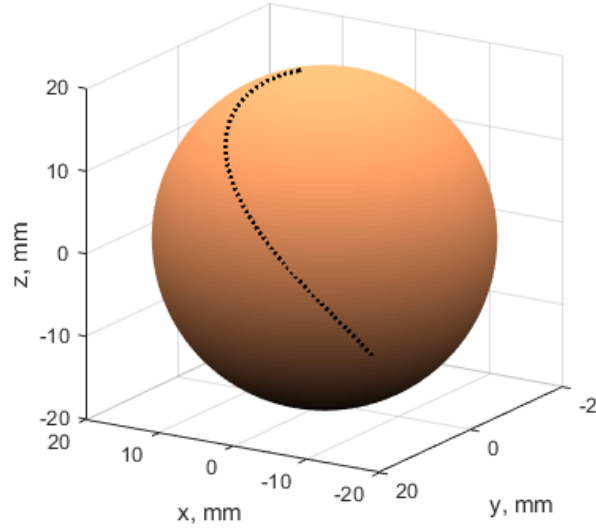
Figure 10. The sphere rotation trajectory (in dots).